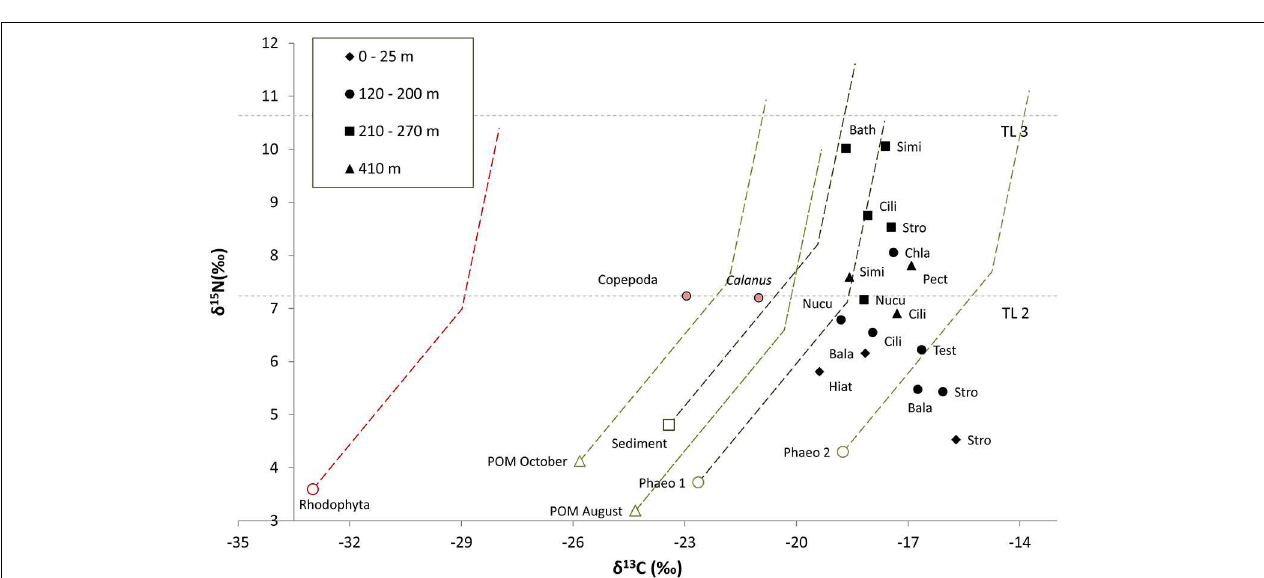
FIGURE 3 | Isotopic composition of carbon sources (average values of all stations) and primary consumers (average values per depth interval). Dashed lines represent fractionation lines between potentail carbon sources and primary consumers assuing an intial fractionation of 4 ‰ between TL 1 and 2 and then 1 ‰ between TL 2 and 3 for δ 13 C, and 3.4 ‰ for δ 15 N between each TL. Copepoda and POM August are the averages of all Copepoda and POM samples, respectively from stations P11–P24 (collected in August). Calanus spp. is the average of the Calanus from